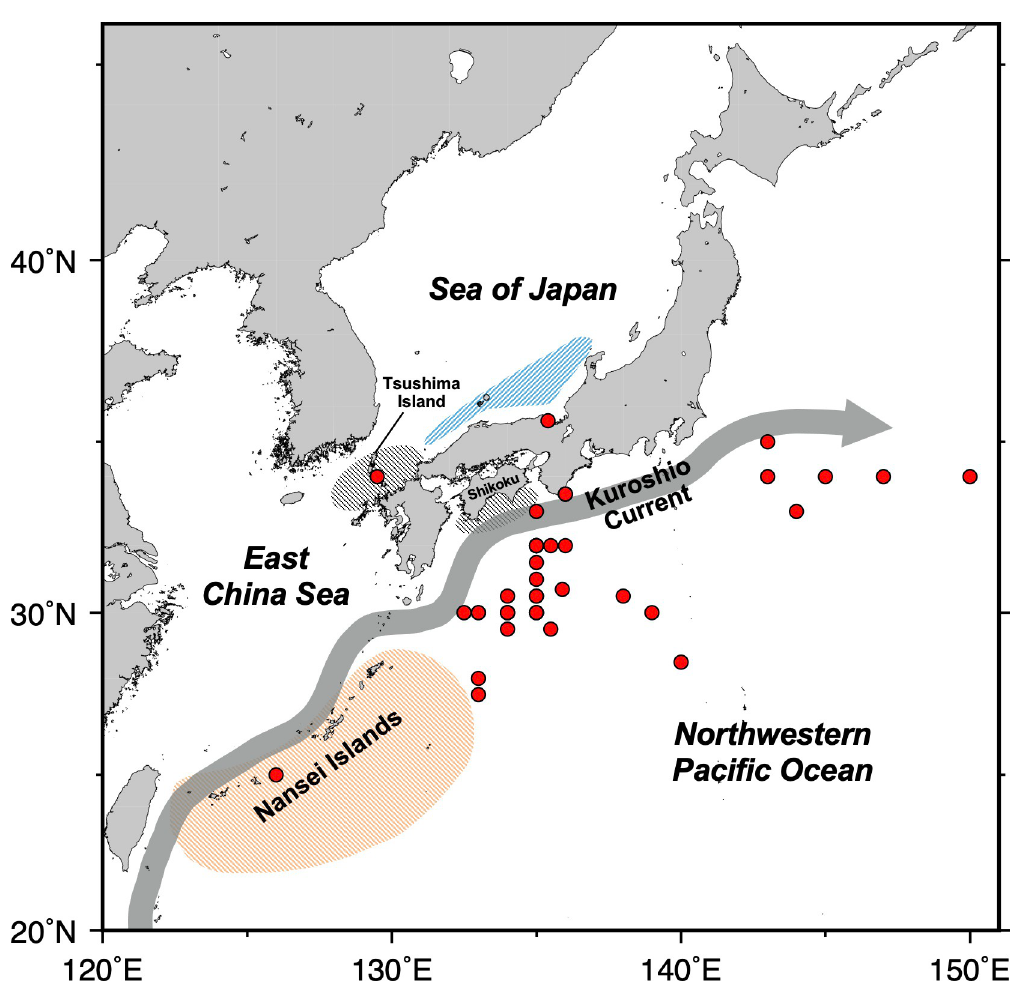
Fig 1. Map showing two major spawning grounds of Pacific bluefin tuna. Colors represent the spawning ground in the southwest of the Sea of Japan (blue shade) and the Nansei Islands area (orange shade). Juvenile nursery areas are shown in the black-shaded areas. Red circles indicate catch locations of the fish samples used in this